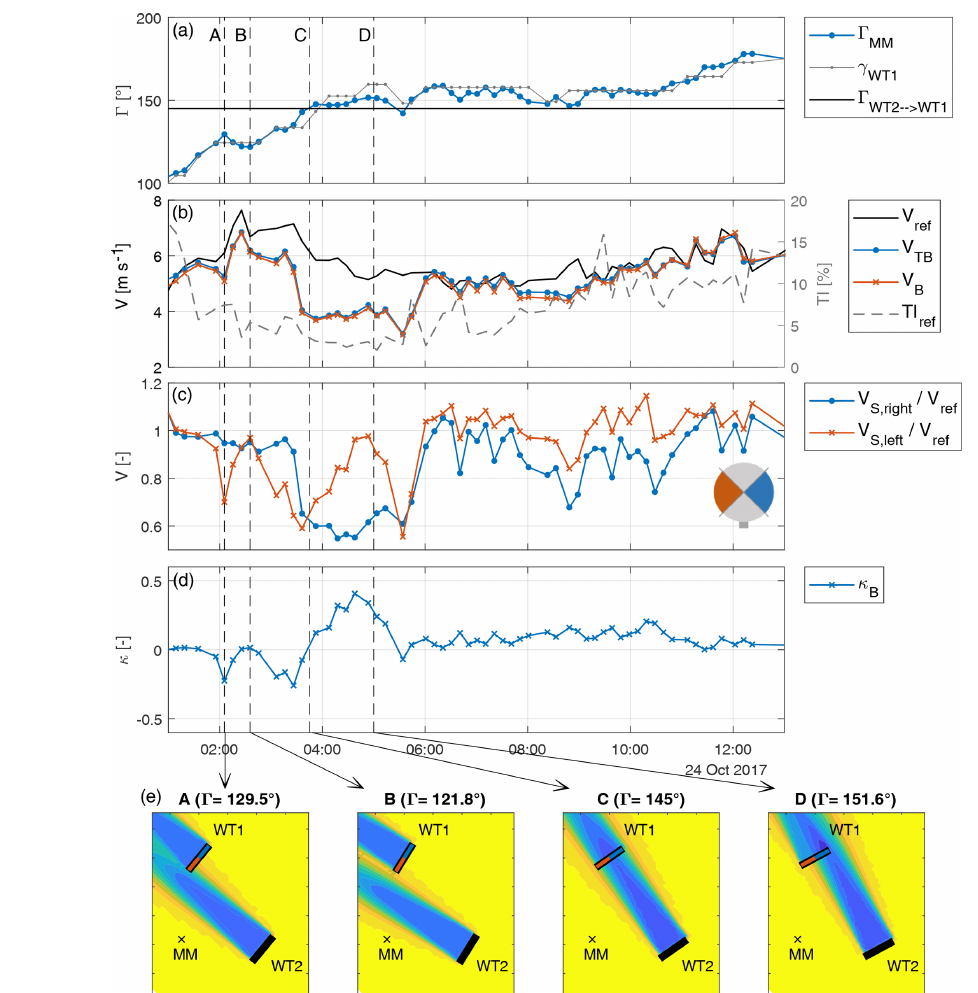
Figure 12. Time series characterized by varying wake interference conditions, with met-mast wind direction and turbine yaw orientation (a) , reference met-mast wind speed, rotor-effective wind speed estimates and reference turbulence intensity (b) , left and right sector-effective speed estimates (c) , and horizontal shear estimate (d) . (e) Wake visualizations based on the FLORIS model for different wind directions at time instants A through